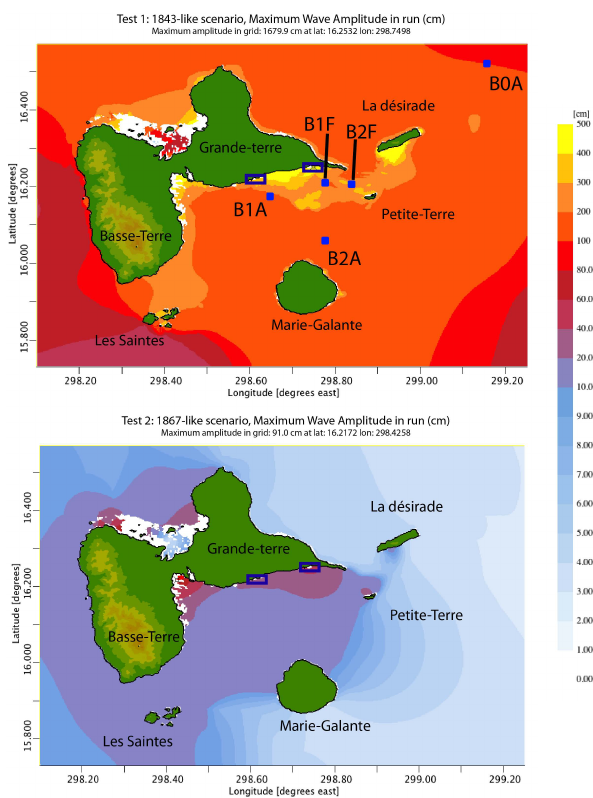
Fig. 7. Maximum wave amplitudes around Guadeloupe obtained with ComMIT software with a 1843-like scenario (Test 1) and a 1867-like scenario (Test 2). Synthetic tide gage locations are rep- resented with blue squares on grid B: B1A, B2A for Sainte-Anne, B1F and B2F for Saint-Franc¸ois; B0A for both sites. Rectangles symbolize Sainte-Anne and Saint-Franc¸ois areas. The color scale is given in